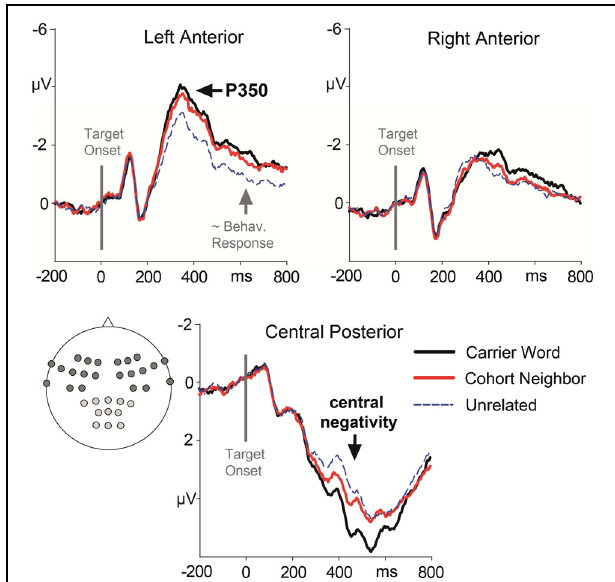
FIGURE 3 | Scalp-topography of voltage differences between the unrelated condition and the carrier word condition (above), between the unrelated condition and the cohort neighbor condition (middle), and between the cohort neighbor condition and the unrelated condition (below). Difference topographies are illustrated for the left side of the head (left), for the back of the head (middle) and for the right side of the head (right). The first time window (300–400 ms) is represented by ERP differences at 350ms (left topographies). The second time window (400–600 ms) is represented by ERP differences at 500ms (right